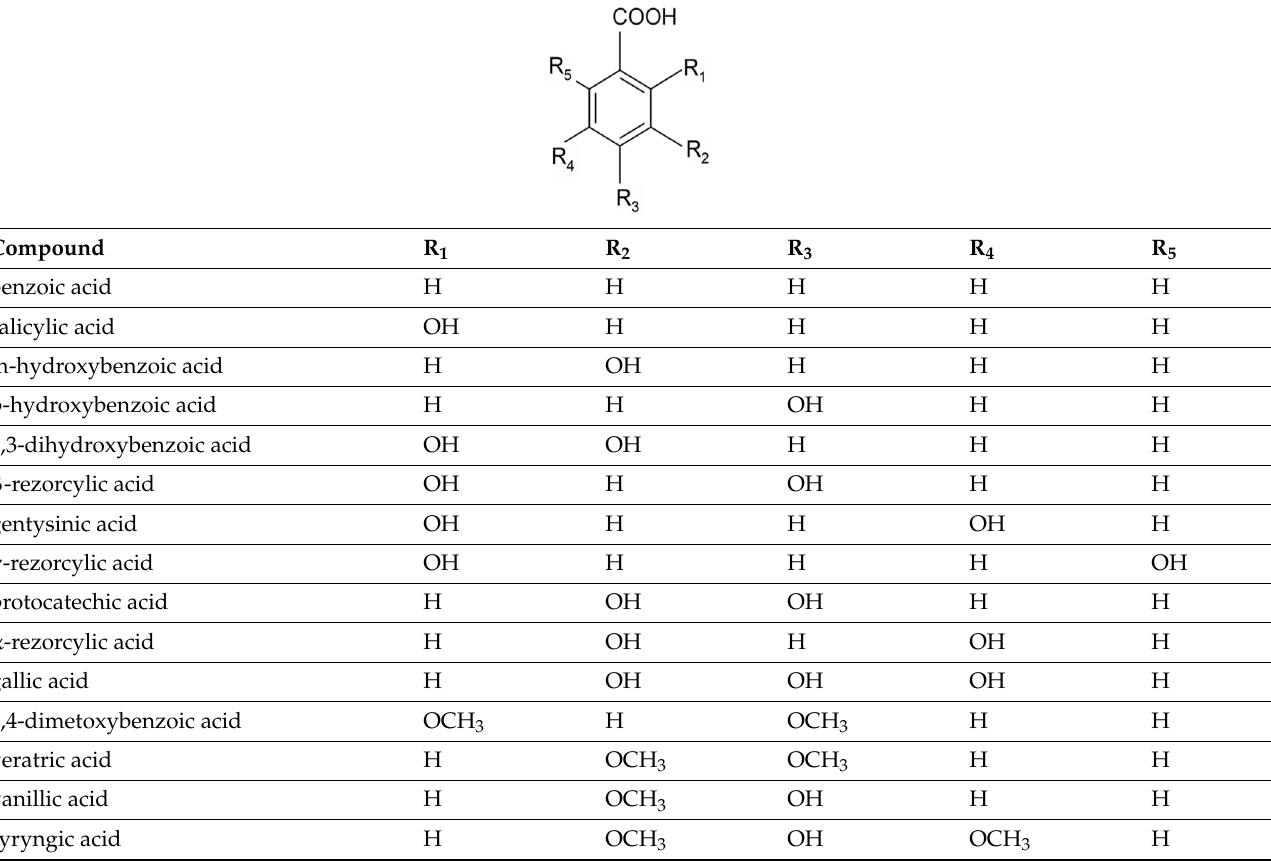
Table 3. Structural formulas of selected benzoic acid derivatives.